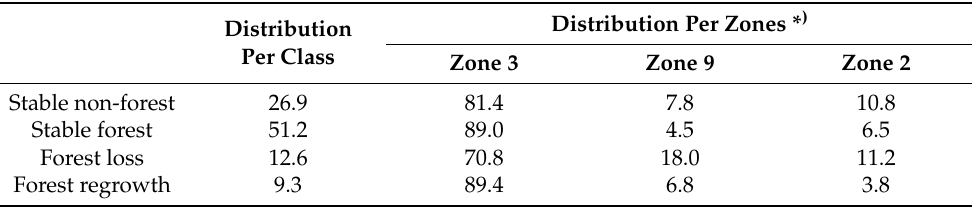
Table 1. Distribution of the sample units per classes and zones (%) for automated digital processing (ADP) map in 2012–2018.